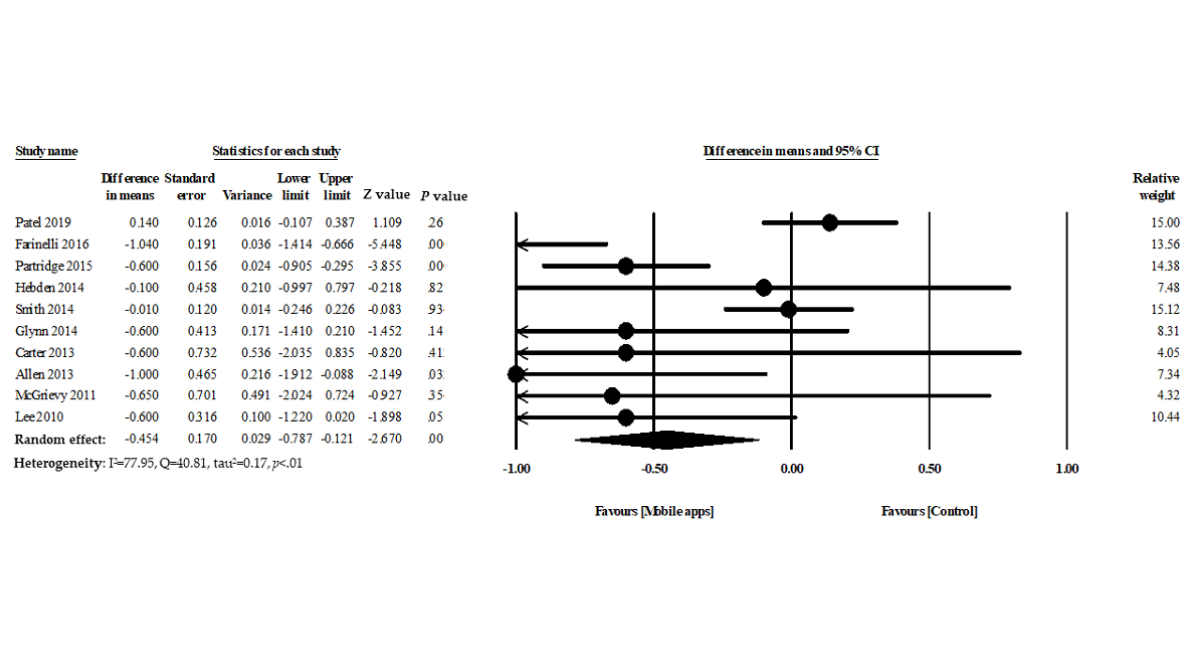
Figure 4. Forest plot of mobile phone app interventions and change in